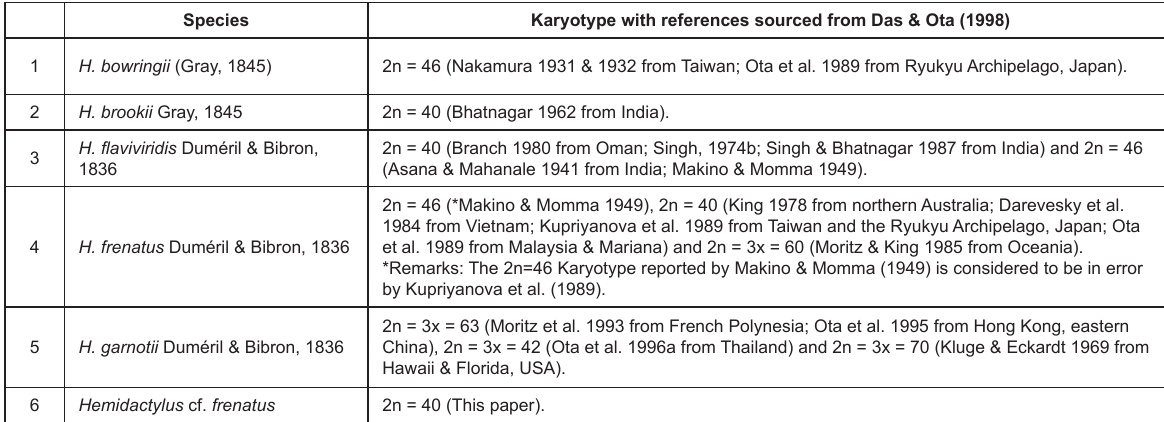
Table 2. Chromosome numbers of Hemidactylus species found in India Species Karyotype with references sourced from Das & Ota